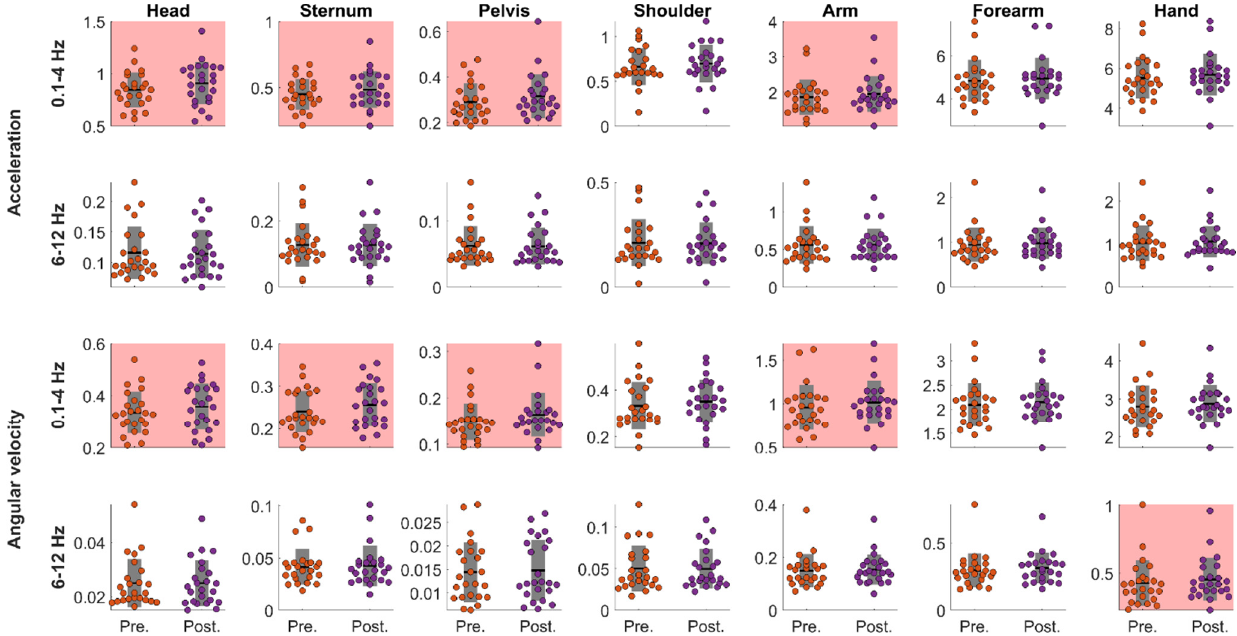
Figure 4. Pre- versus post-RPT work tasks power spectrum for the acceleration and angular velocity in the 0.1–4 Hz and 6–12 Hz frequency bands for the head, sternum, pelvis, shoulder, arm, forearm, and hand. Dots represent each participants’ data. Black horizontal lines represent the participants means; grey bars represent standard deviations. Pink backgrounds indicate significant differences between Pre- and post-RPT work tasks.